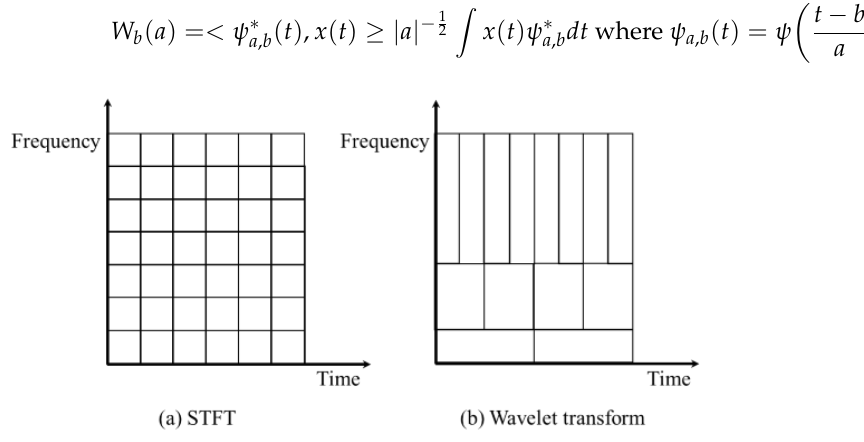
Figure 1. Time–Frequency resolution of ( a ) STFT and ( b ) CWT.